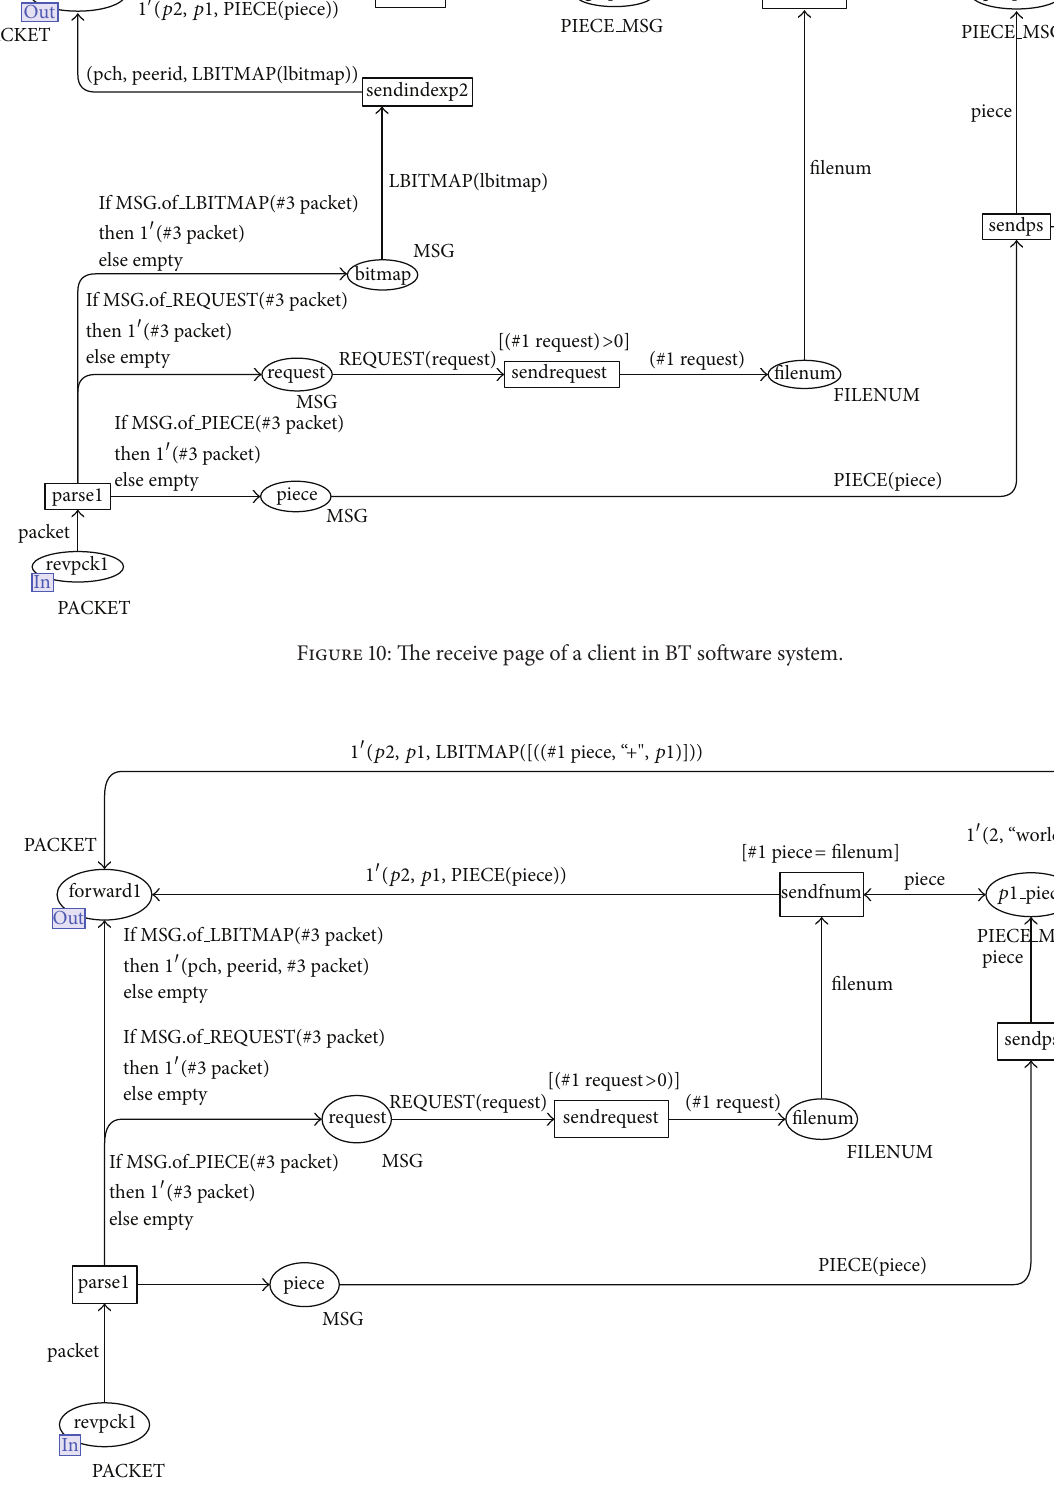
Figure 11: The receive page after